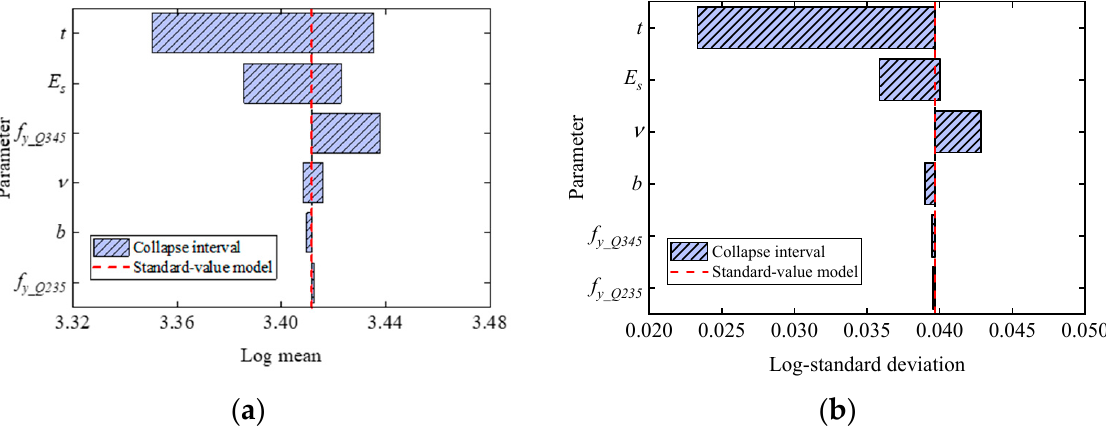
Figure 8. Stripe analysis results. The log mean interval of the basic collapse wind speed corresponding to each pa- rameter is shown in Figure 9a. The vertical dotted line represents the log-mean value of the collapsed wind speed of the standard value model, the end of each bar represents the analysis result of the lower- or upper-limit-value model, and the length of the bar reflects the impact level of its corresponding parameter on the basic collapse wind speed of the transmission tower. The bar length of the angle steel thickness was the largest, as shown in Figure 9a, indicating that the angle steel thickness had the greatest impact on the collapsed wind speed when the tower was in operation. The yield strength of Q345 steel and elastic modulus also had a significant effect on the collapse of the transmission tower. The width of the angle steel had a slight effect on the wind-resistant performance of the tower because the measured values of the angle steel width were close to the standard value according to the statistical results of the relevant research [32]. The bar length of the yield strength of Q235 steel was the minimum, which was due to the stress and deformation of the diagonal members of the transmission tower in this paper were relatively small. However, the results will be different for transmission towers with large stress on diagonal members.